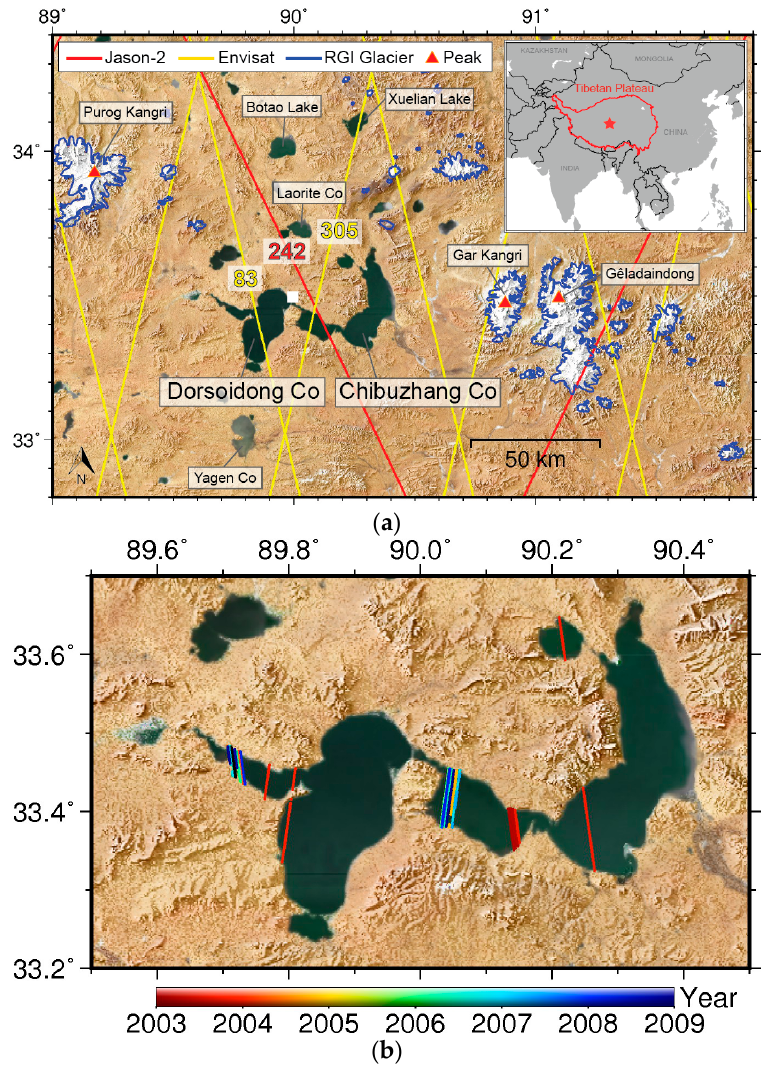
Figure 1. ( a ) Locations of Chibuzhang Co, Dorsoidong Co, and Tanggula glacier system in the central TP. The boundary of TP and relative location of study site is displayed in the overview map. Yellow and red lines in the main figure are Envisat and Jason-2 ground tracks, respectively. White square near 33.5°N and 90°E is the center of GRACE 2° × 2° grid. Blue outline of glaciers is from the Randolph Glacier Inventory (RGI) [19]; and ( b ) a blow up view of this twin lake, with ICESat actual ground tracks color-coded by year of data, 2003–2009. The passes are mainly centered in western basin of each lake.